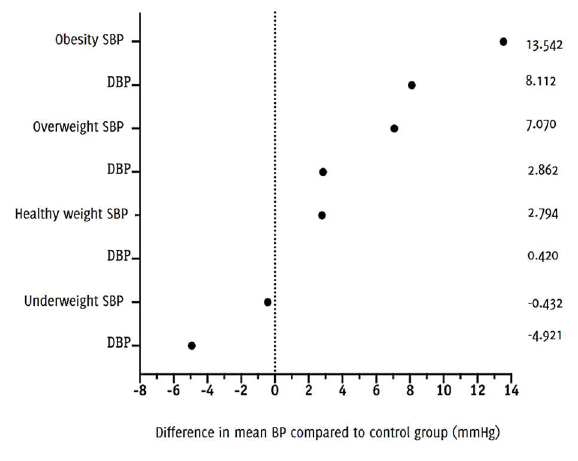
Figure 5 . Change in Mean Systolic and Diastolic Blood Pressure Compared to Non-hypertensives, for Body Mass Index Category.